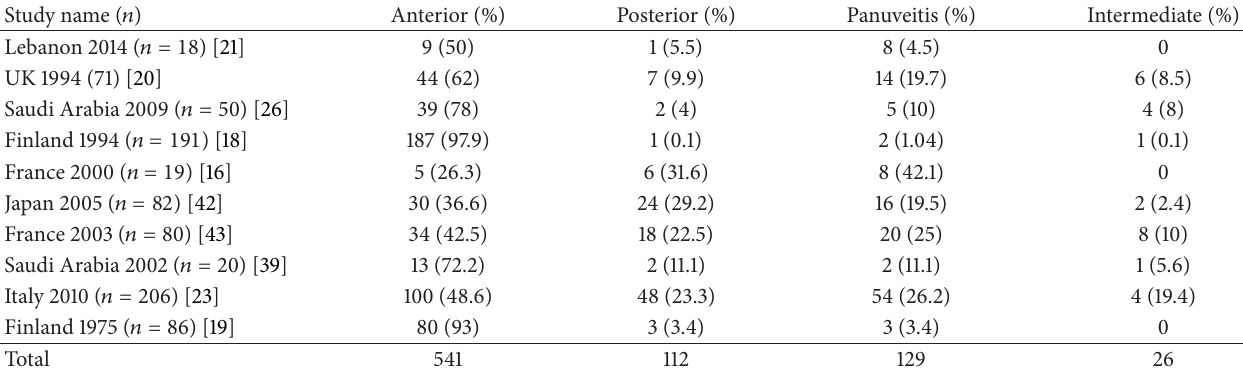
Table 3: Most common location of uveitis in elderly patients.